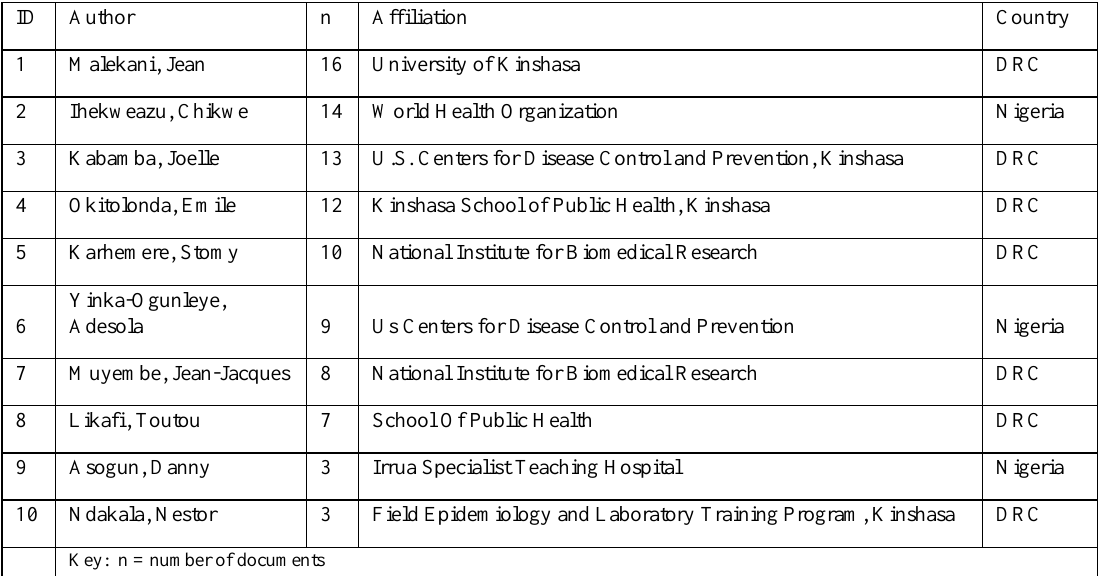
Table 1. Top ten most prolific authors of monkey pox related research in Africa.